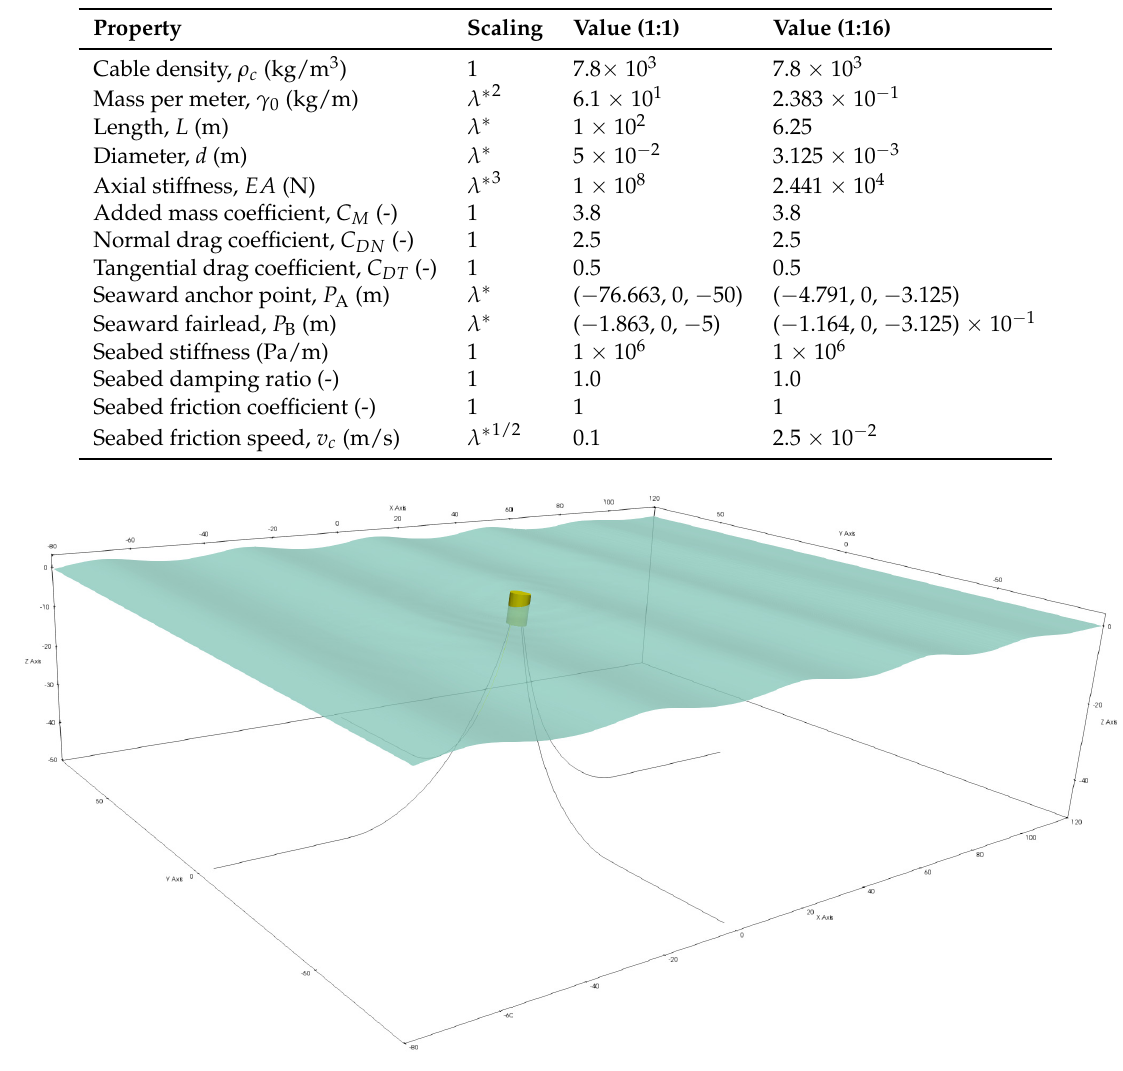
Table 2. Description of the mooring cable properties in prototype scale. Please note that the values of anchor and fairlead positions apply to the seaward cable, facing the wave direction. The other three mooring cables are found from rotation about the vertical axis with 90, 180, and 270 degrees respectively.